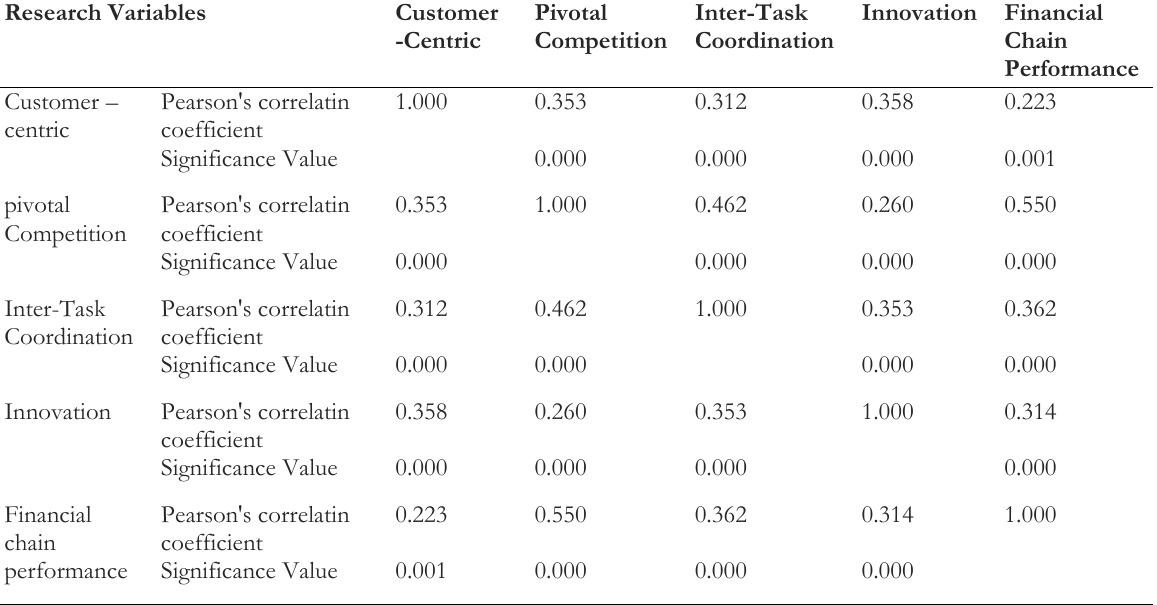
Table 6. Coefficients of correlation between research variables.